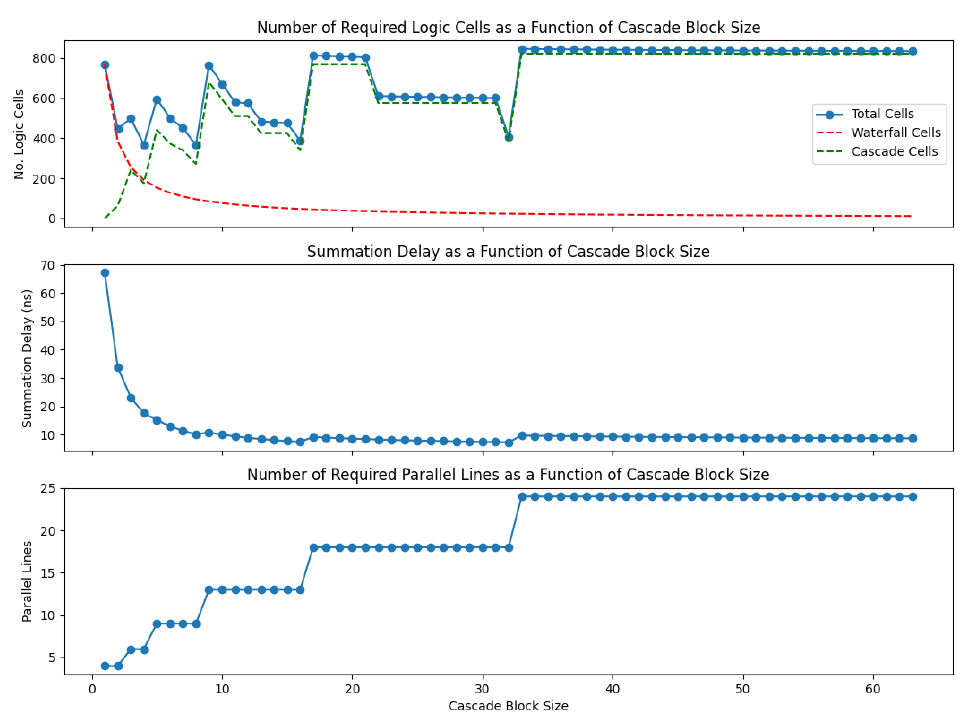
Figure 10. Effect on summation delay, number of parallel lines and number of logic gates of varying the size of the cascade block in mixed cascade/waterfall summation